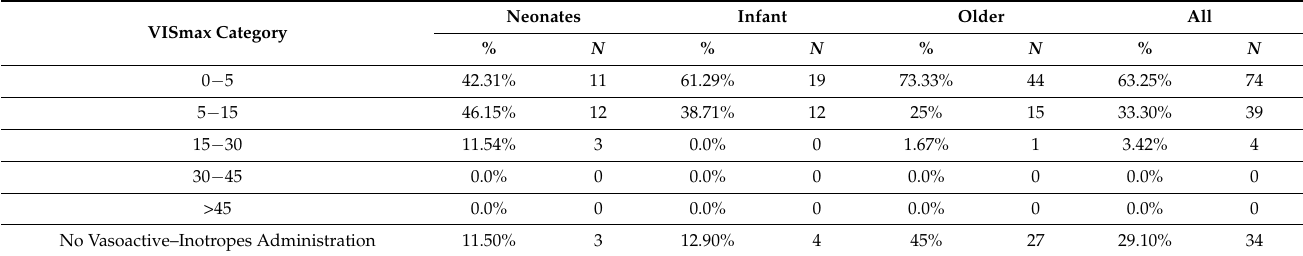
Table A3. Categorical distribution of vasoactive or inotropes drugs at Time 1.